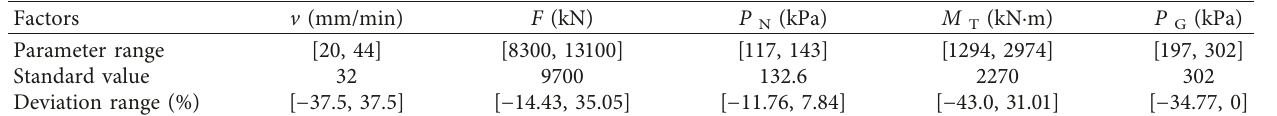
Figure 6: Variations in the TBM parameters at different excavation speeds (data from XW section): (a) total thrust versus excavation speed; (b) cutter head torque versus excavation speed; (c) face pressure versus excavation speed; (d) grouting pressure versus excavation speed. Table 6: Standard values and ranges of excavation speed and